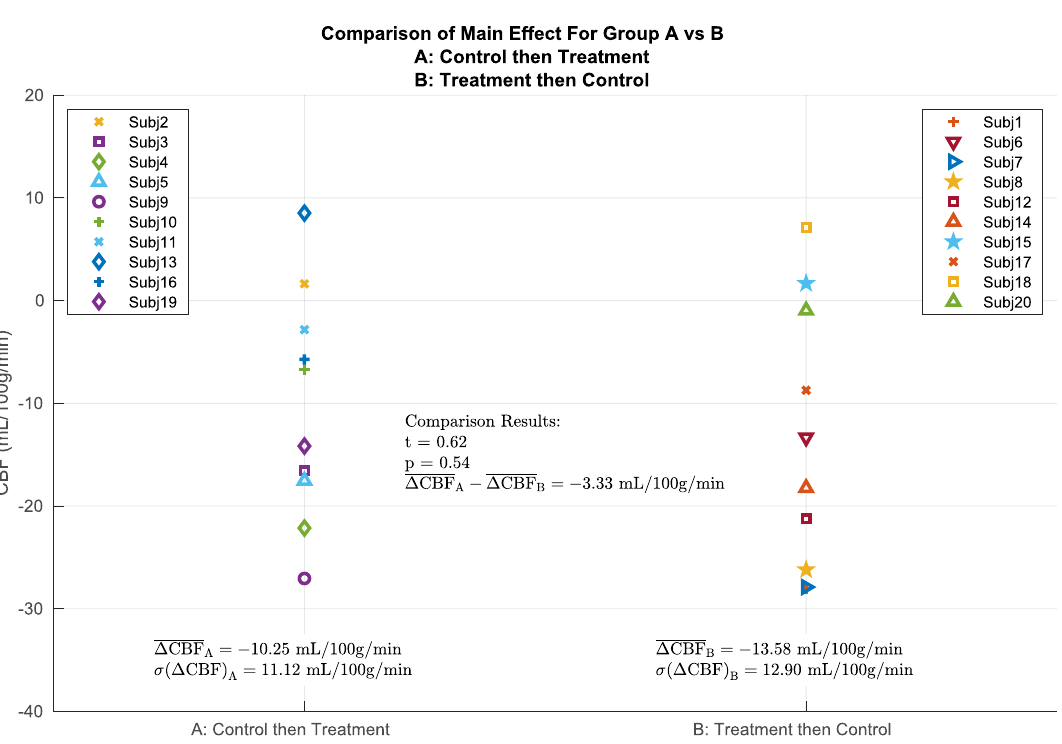
Figure 4. The main effect for any significant differences in effect between the subjects randomized to A: Control then Treatment vs B: Treatment then Control. The plot below shows the main contrast values of (Post–Pre) treatment − (Post–Pre) control within the main contrast cluster reported in Fig. 3. On the left are subjects randomized to group A; on the right are subjects randomized to group B. A two-sided two-sample t-test was performed between the two groups, indicating no significant difference in main effect (p = 0.54) between the two session